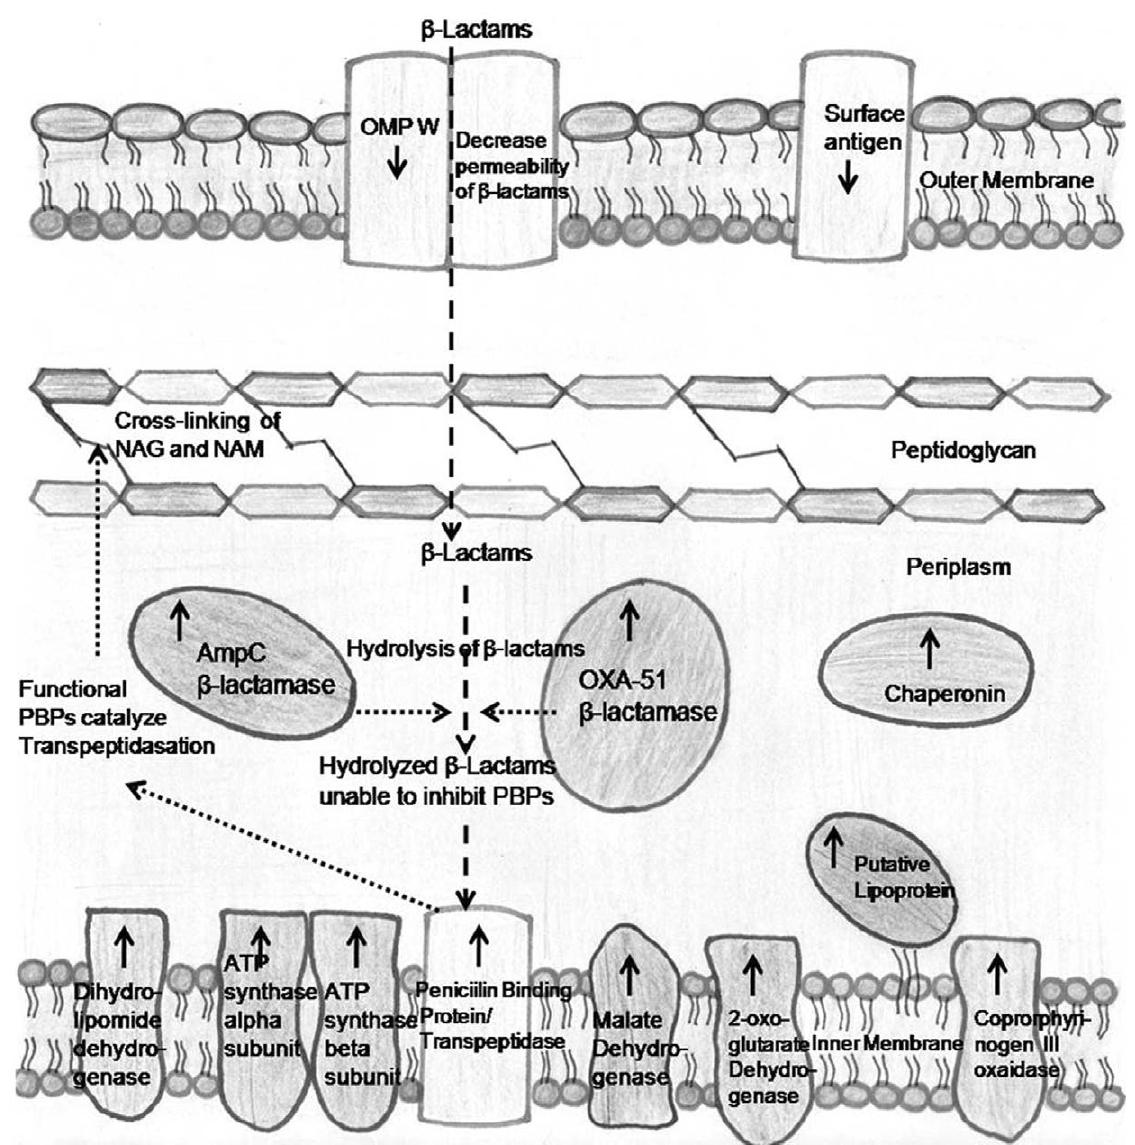
Figure 2. Schematic presentation of upregulated ( q ) and downregulated ( Q ) proteins in the carbapenem-resistant A.baumannii .